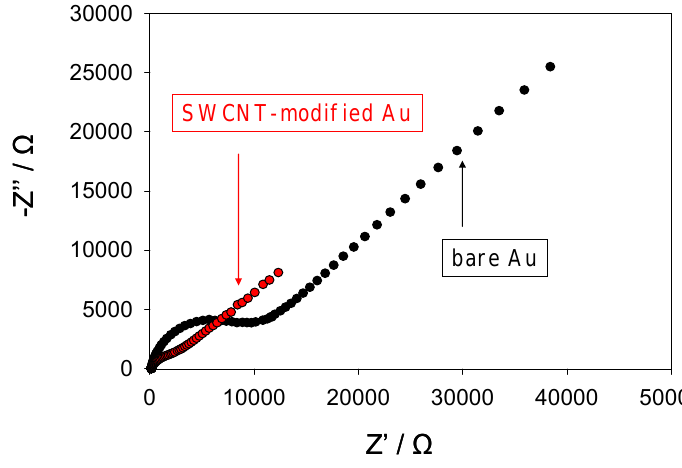
Figure 9. Complex impedance Nyquist plots recorded for ferricyanide reduction at Au and SWCNT modified Au